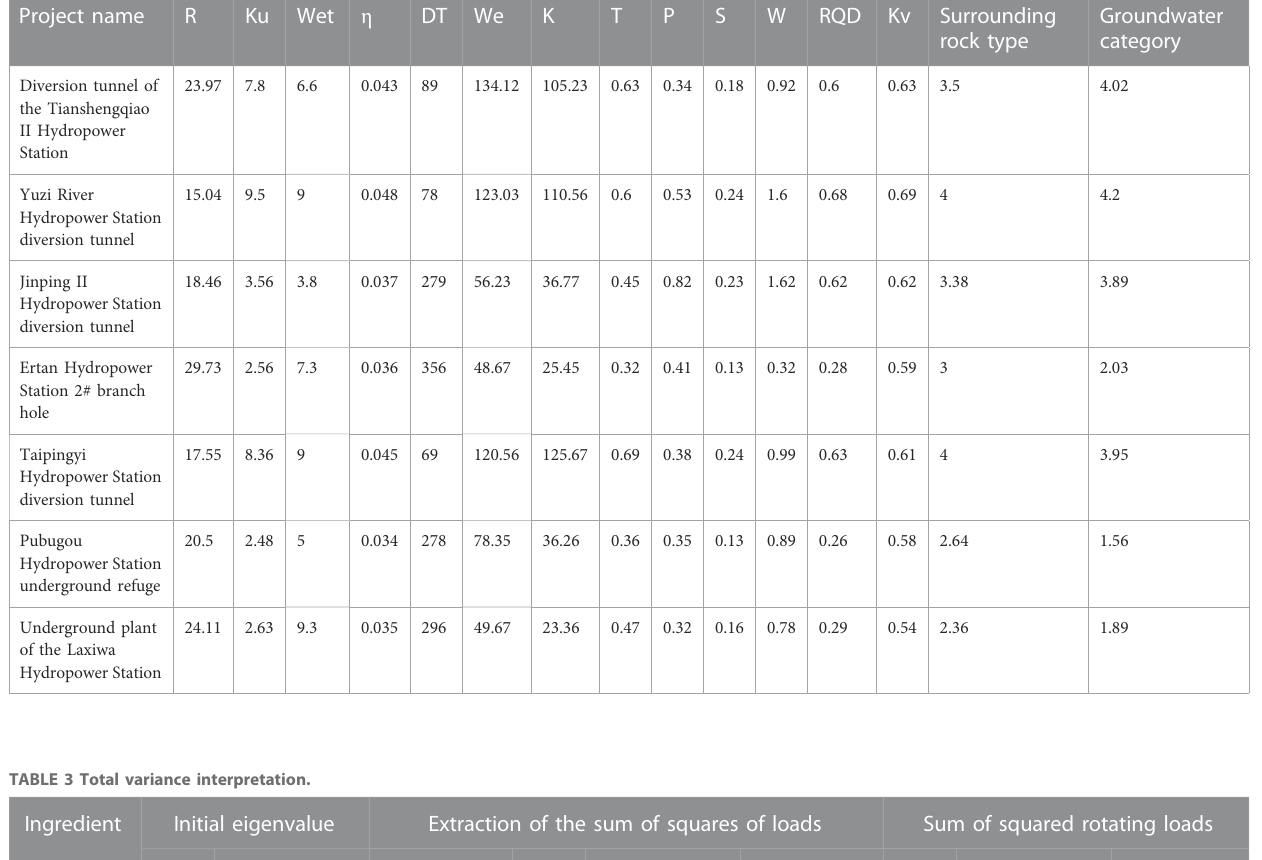
TABLE 2 Rockburst evaluation indexes of each project.